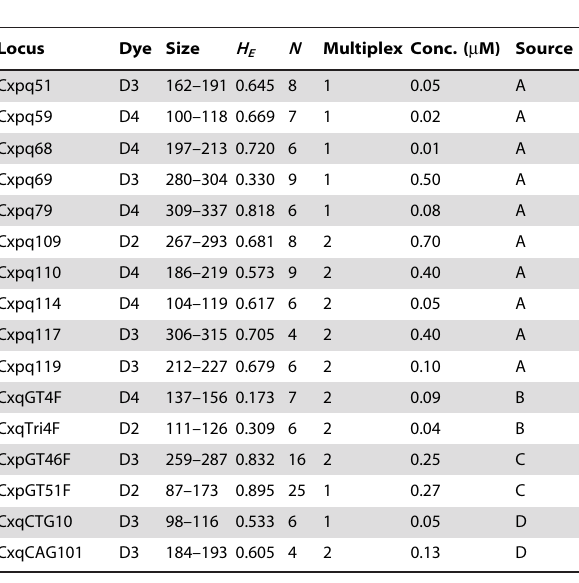
Dye, fluorescent label (D2=black, D3=green, D4=blue); Size, range of allele sizes (in bp); H E Expected Heterozygosity averaged across populations; N, number of alleles; Multiplex, which multiplex this locus is part of; Conc., concentration of each primer; Source, original source of locus: A [6], B [8], C